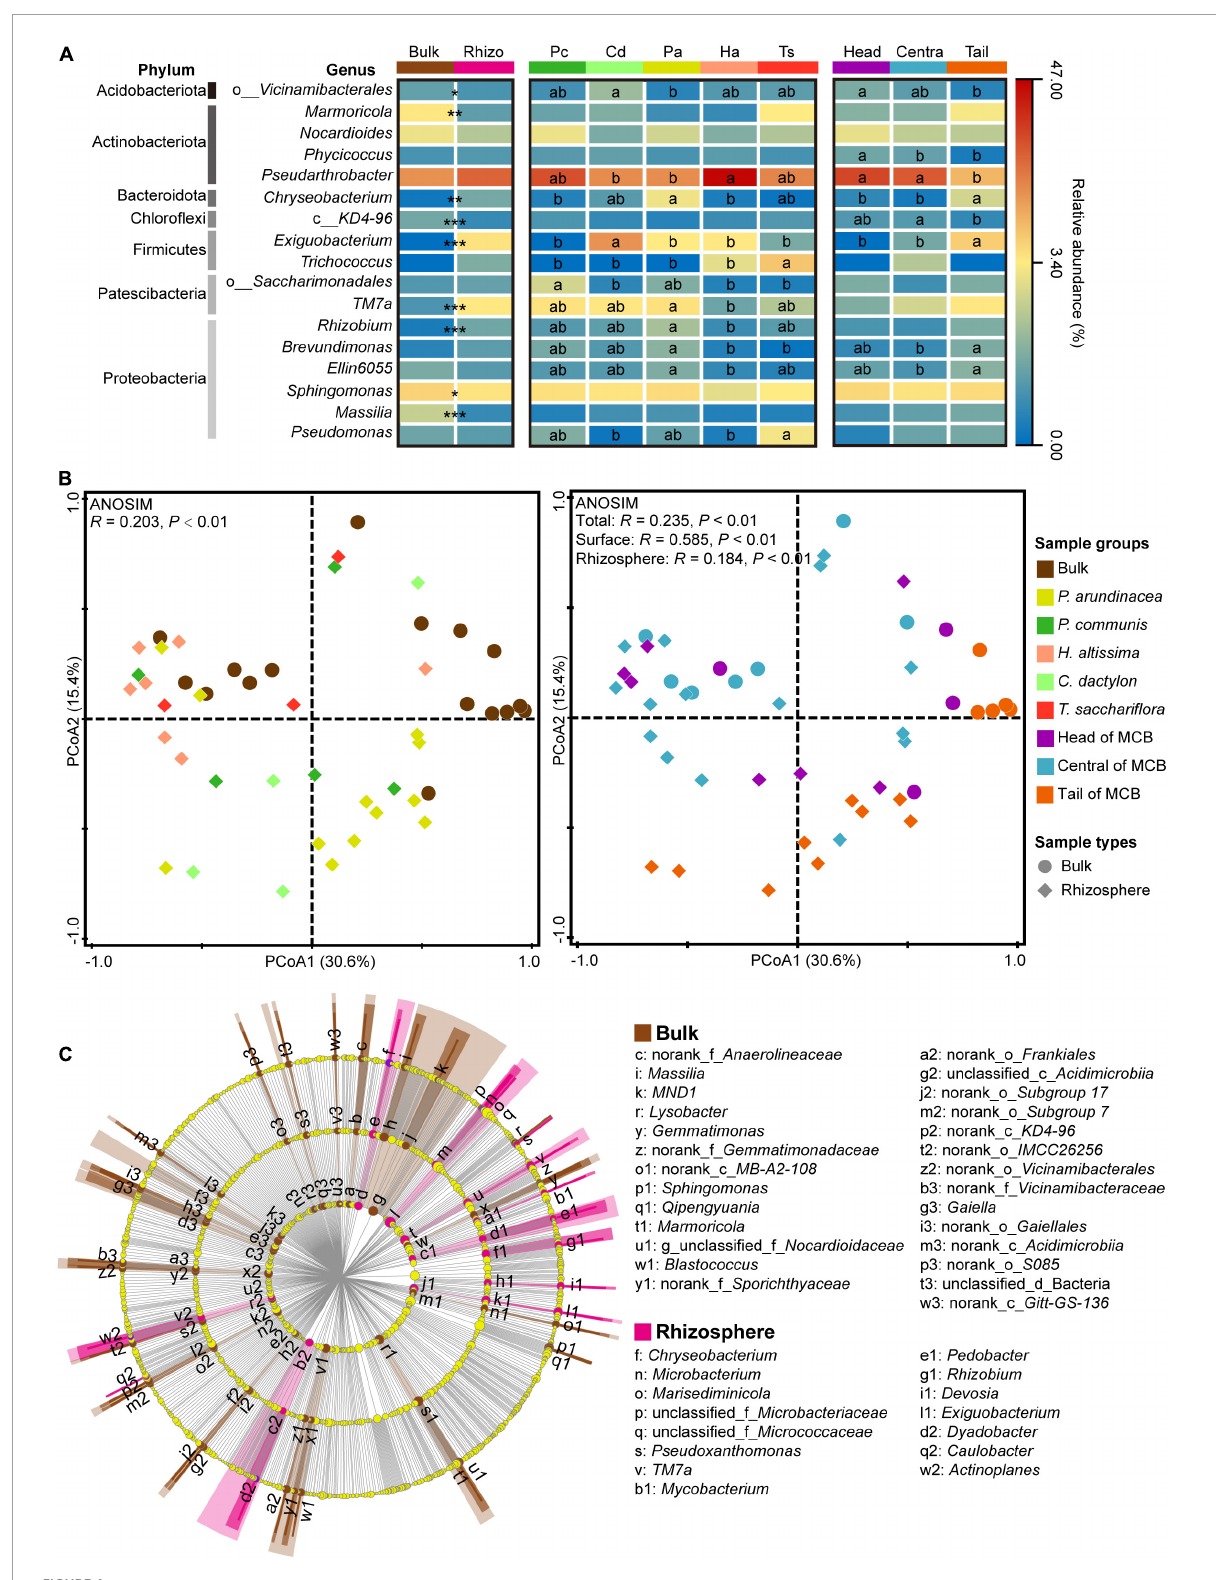
FIGURE4 Bacterial communities in bulk and rhizospheric soils. (A) The abundance of dominant bacterial genera (relative abundance > 1%) across different soil sample groups (bulk and rhizosphere, plant species, spatial parts). “*,” “**,” and “***” indicate the significant differences in the abundance of dominant bacterial genera between bulk and rhizospheric soils at P < 0.05, 0.01, and 0.001 based on the Mann-Whitney U test, respectively.